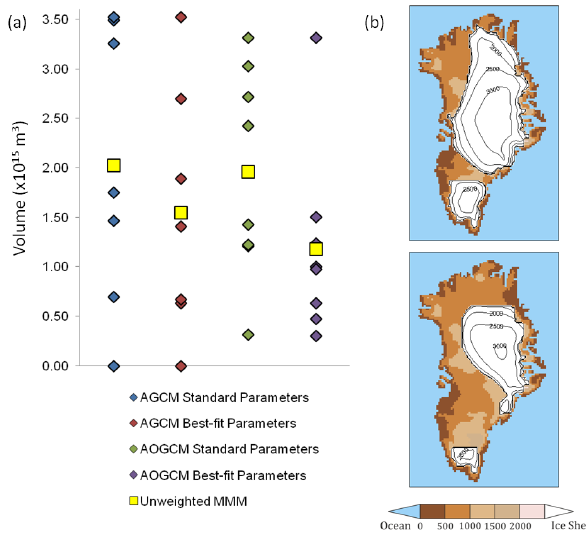
Figure 13. (a) Summary of the spread of mPWP GrIS volumes for each model within the PlioMIP ensemble (AGCM and AOGCM) compared with the un-weighted MMM for either the standard BA- SISM glaciological parameter set or for the parameter set that gives the “best” volumetric representation of the modern GrIS. (b) Ice sheet configuration with the closest volume equating to the largest (top) and smallest (bottom) MMM